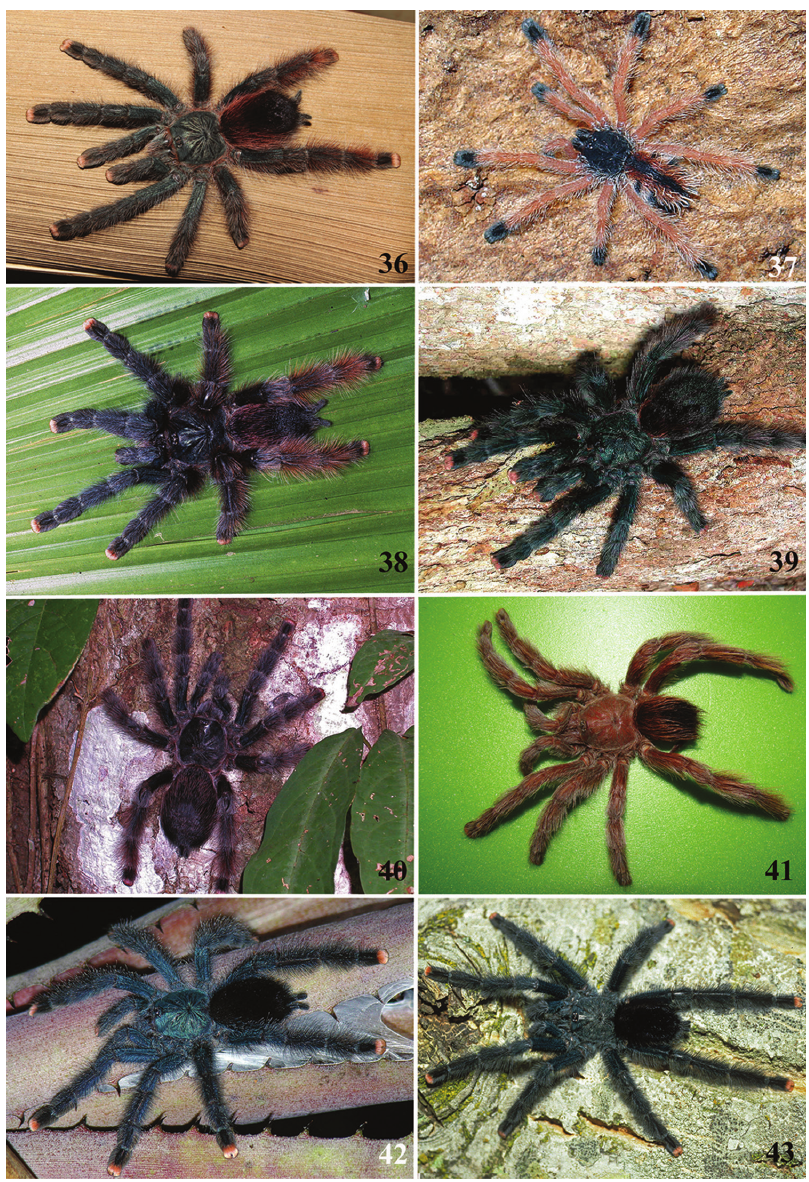
Figures 36–43. Avicularia avicularia (Linnaeus, 1758) morphotypes. 36–37 morphotype 1 36 female from Castanhal, state of Pará, Brazil 37 immature from Santarém, state of Pará, Brazil 38 morphotype 2, female from Tucuruí, state of Pará, Brazil 39 morphotype 3, female from Caracas, Distrito Capital, Ven- ezuela 40 morphotype 4, female from Tambopata, department of Madre de Dios, Peru 41 morphotype 5, preserved female from Manuripi, department of Pando, Bolivia 42–43 morphotype 6 42 female